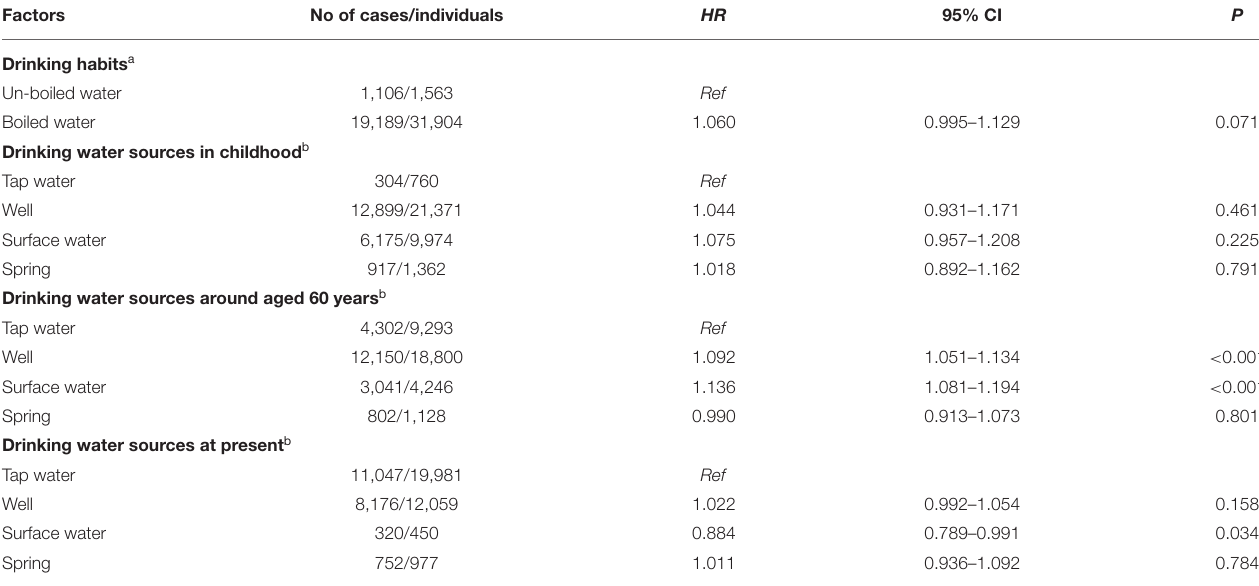
TABLE 2 | The associations of lifespan drinking water sources and habits with all-cause mortality ( N = 33,467).